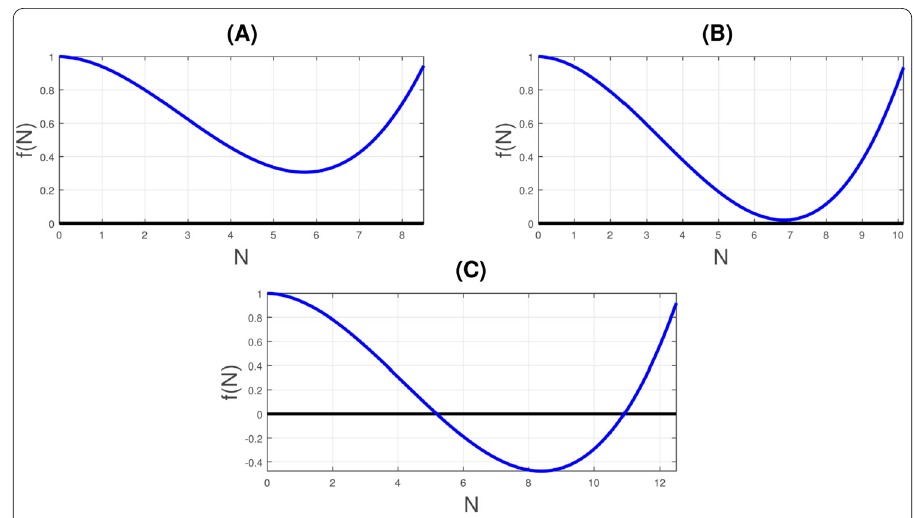
Figure 1 Existence of DFE for the values r = 1.2, λ = 0.02, μ = 2.5, e = 0.8, a = 0.5, β = 3.5, η = 0.5, where for ( A ) we considered k = 8.5. We have no existence of the DFE for ( B ), we take k = 10.15, hence we have